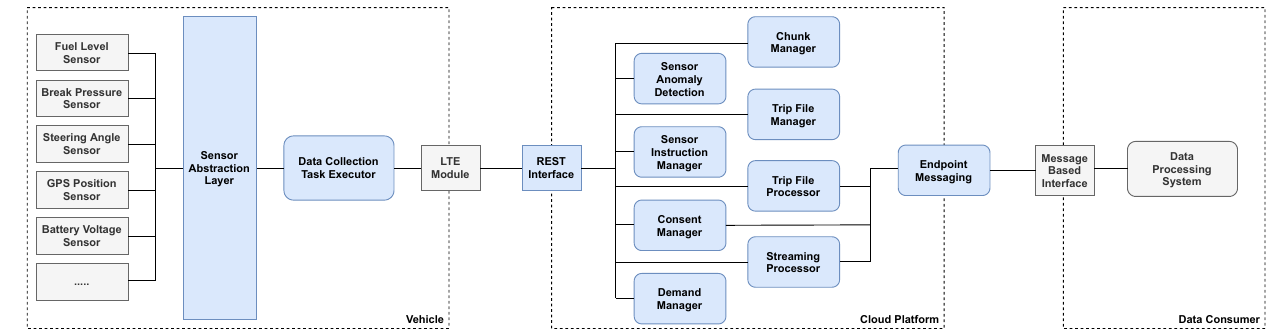
Figure 5. High-level architecture of the proposed system. Components that we have developed are coloured